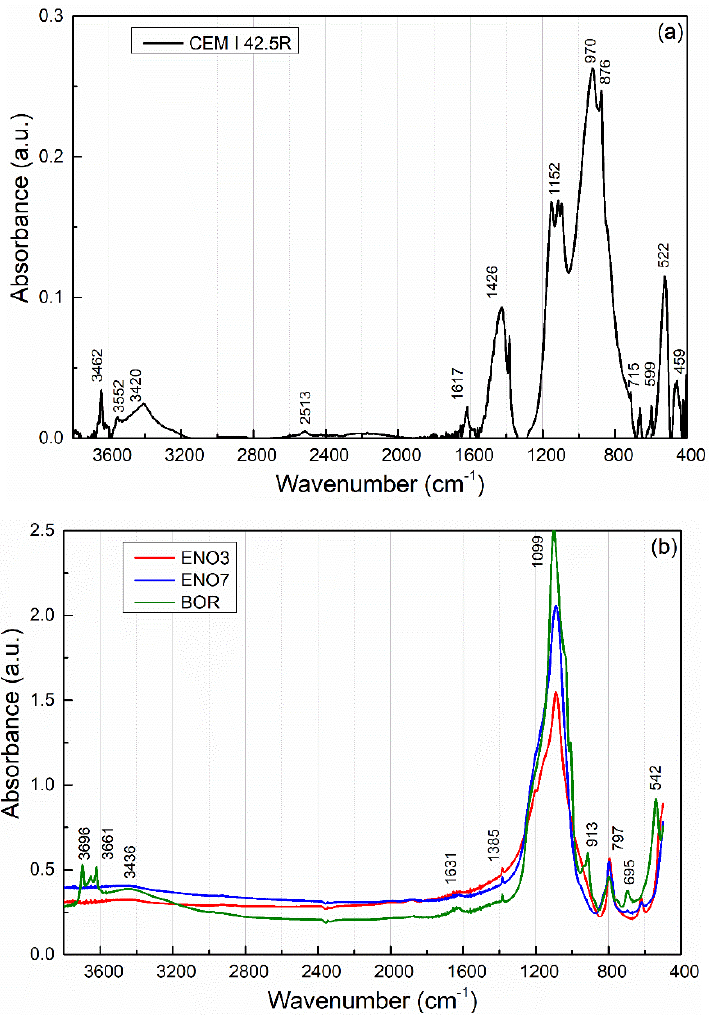
Figure 1. FTIR spectra of raw materials: ( a ) CEM I 42.5R, ( b ) diatomaceous earth. Tables 3 and 4 show the assignment of the major absorption bands of the tested raw Table 3 . Assignments of the major absorption bands of CEM I 42.5 R, Radotín [57] .